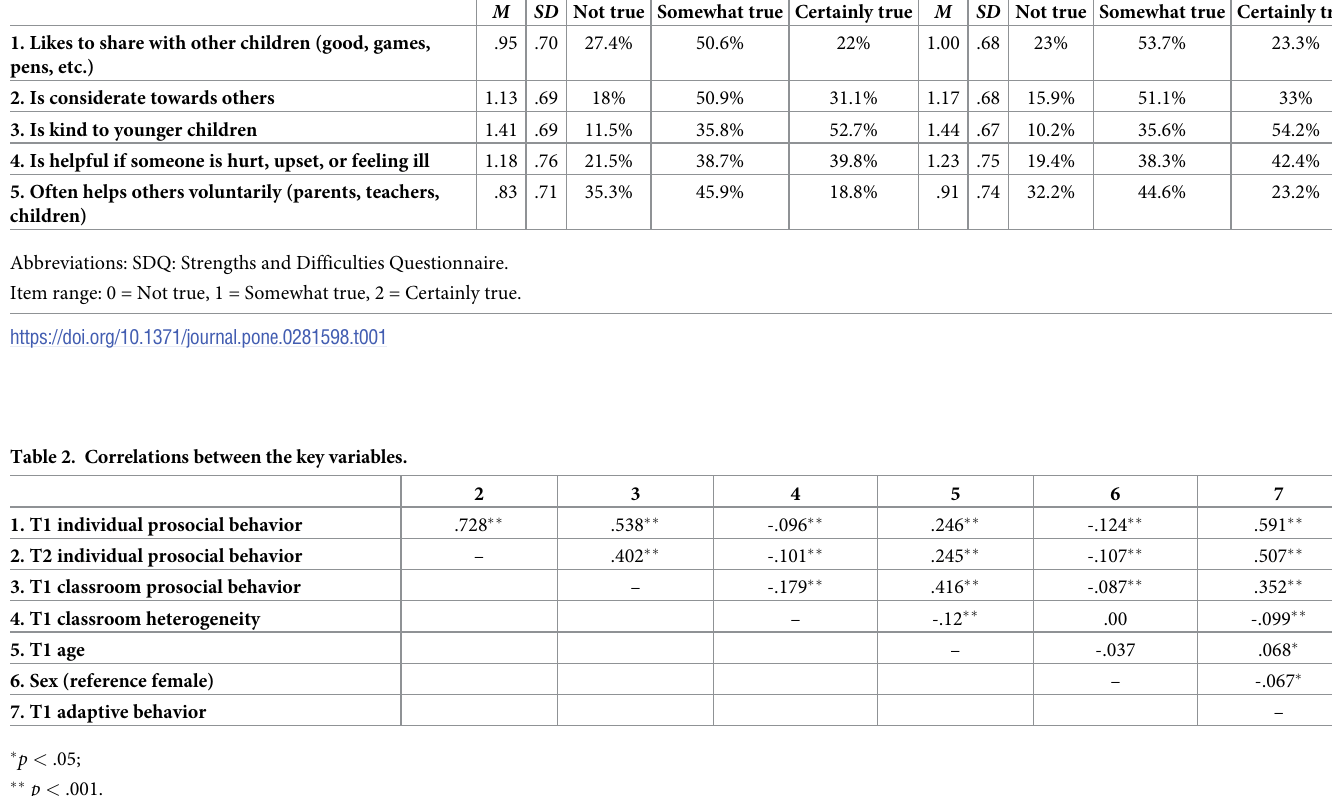
Table 1. Item means (M), standard deviations (SD) and percentages on the SDQ prosocial subscale at both timepoints (T1 and T2). T1